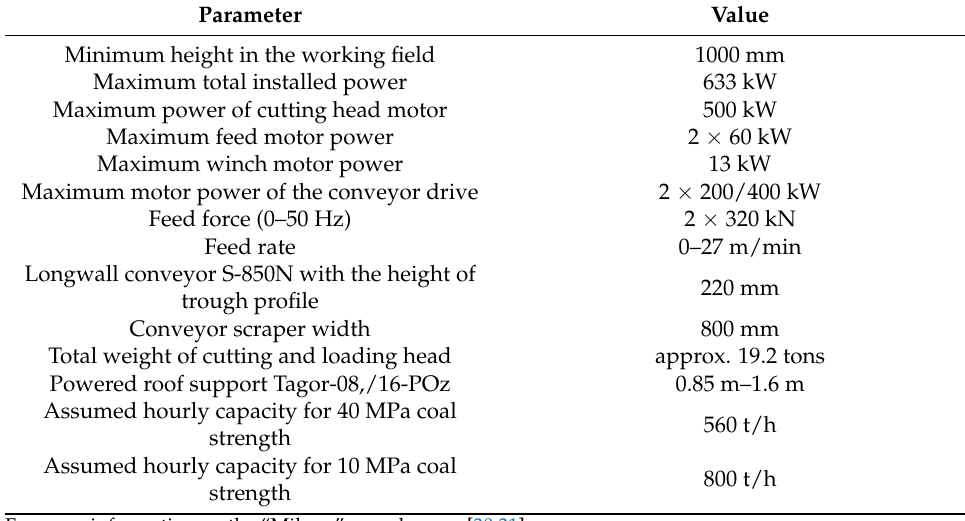
Table 1. Cont. Parameter Value Minimum height in the working